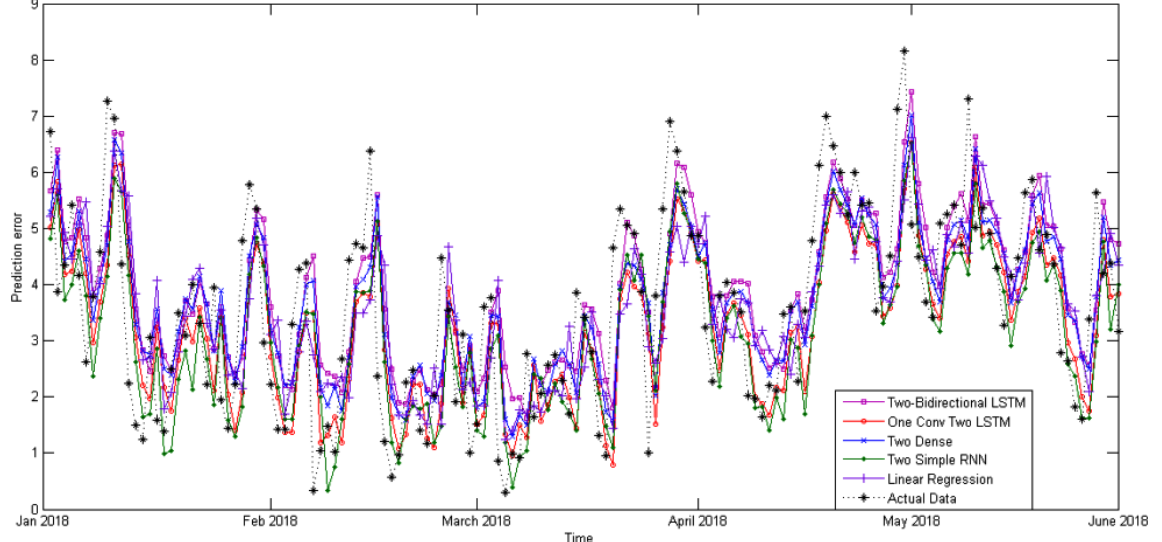
Figure 3. Prediction plot of wind speed data of considered model in Chennai Dataset from Jan 2018 to June